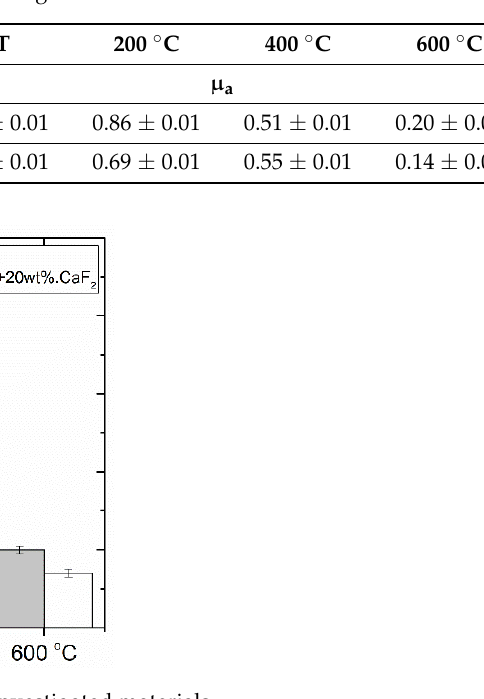
Figure 19. Average friction coefficient (µ a ) of investigated